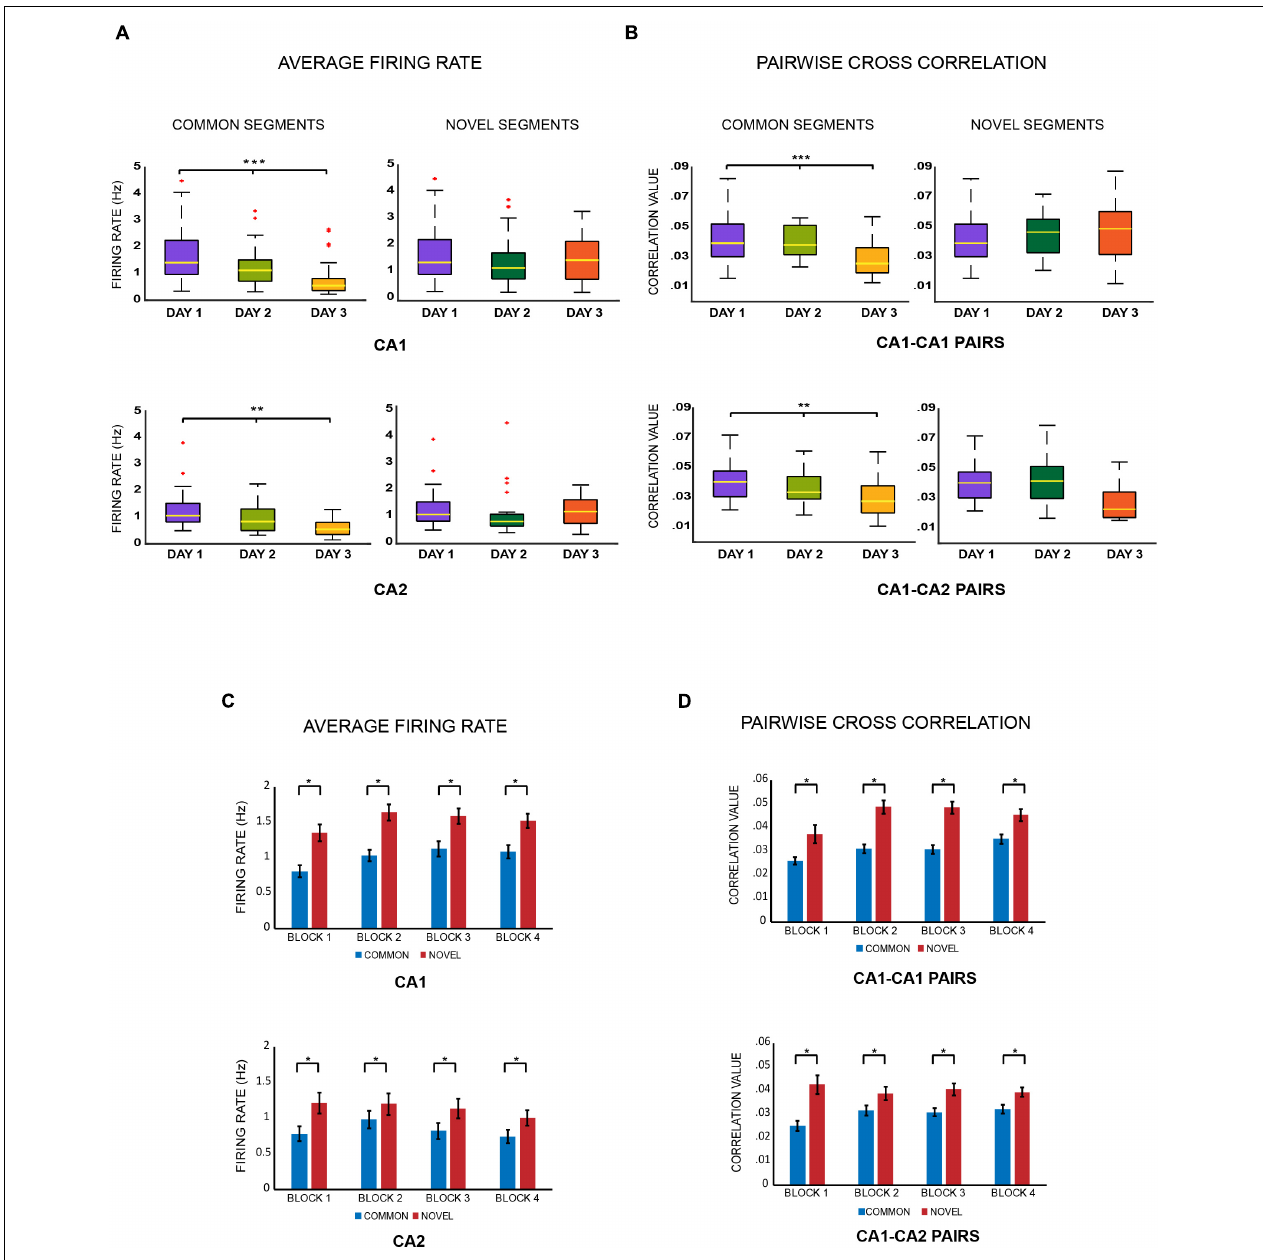
FIGURE 2 | (A) Average firing rates. Boxplots of average firing rates of CA1 and CA2 place cells were constructed for comparing common and novel segments of the tracks across days. As the same spatial area got more familiar, the firing rates of place cells firing for that area decreased over days (*** indicates p < 0.005, ** indicates p < 0.005 and * indicates p < 0.05) (Kruskal–Wallis test: common segments, CA1: p < 0.0001; CA2: p = 0.0034) but not for novel areas (Kruskal–Wallis test: novel segments: CA1 cells: p = 0.259; CA2 cells: p = 0.25). (B) Pairwise cross correlations. Boxplots for pairwise cross correlations of CA1–CA1 and CA1–CA2 cell pairs were also compared for familiar and novel areas across days and depicted the same trend. As the same spatial area got more familiar, pairwise cross correlations of both CA1–CA1 and CA1–CA2 cell pairs firing for that area decreased over days (Kruskal–Wallis test: common segments: CA1–CA1 pairs: p = 0.00006; CA1–CA2 pairs: p = 0.0009) but not for novel areas, where the values remained similar and comparable (Kruskal–Wallis test: novel segments: CA1–CA1 pairs: p = 0.485, CA1–CA2 cell pairs: p = 0.078). (C) Average firing rates – For day 2 and 3, the average firing rates for place cells firing for novel segments were combined and compared against those that were firing for common segments. This was conducted for all the four recording blocks separately. For all blocks, the average firing rates for novel segments were higher than those for common segments for both CA1 and CA2 ensembles (Jonckheere-Terpstrsa test: common vs. novel segments: CA1 cells: p = 0.0104, CA2 cells: p = 0.01). (D) Pairwise cross correlations – The same comparisons were extended to CA1–CA1 and CA1–CA2 cell pairs, whereby the same trend was observed, where correlation for cell pairs firing for novel segments were higher than those firing for common segments of the track across all 4 blocks (Jonckheere-Terpstrsa test: CA1 vs. CA2 cells: common segments: p = 0.0104, novel segments: p = 0.02).